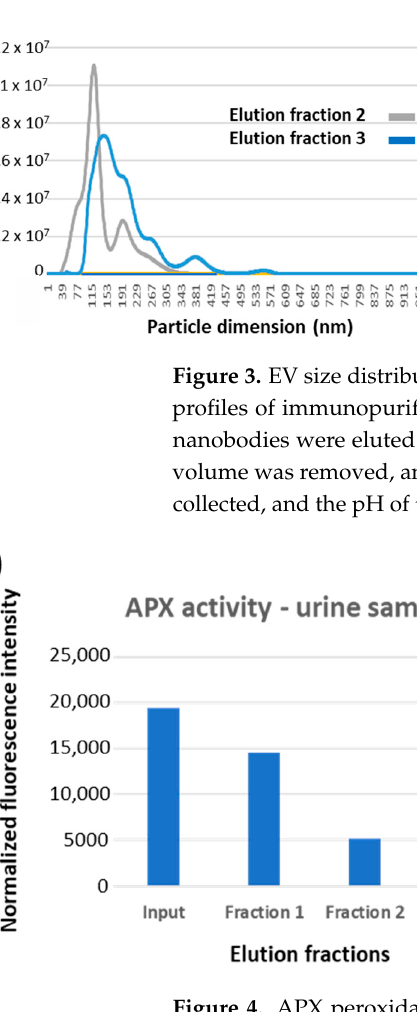
Table 2. Characteristics of the EVs eluted from the monolith filter .